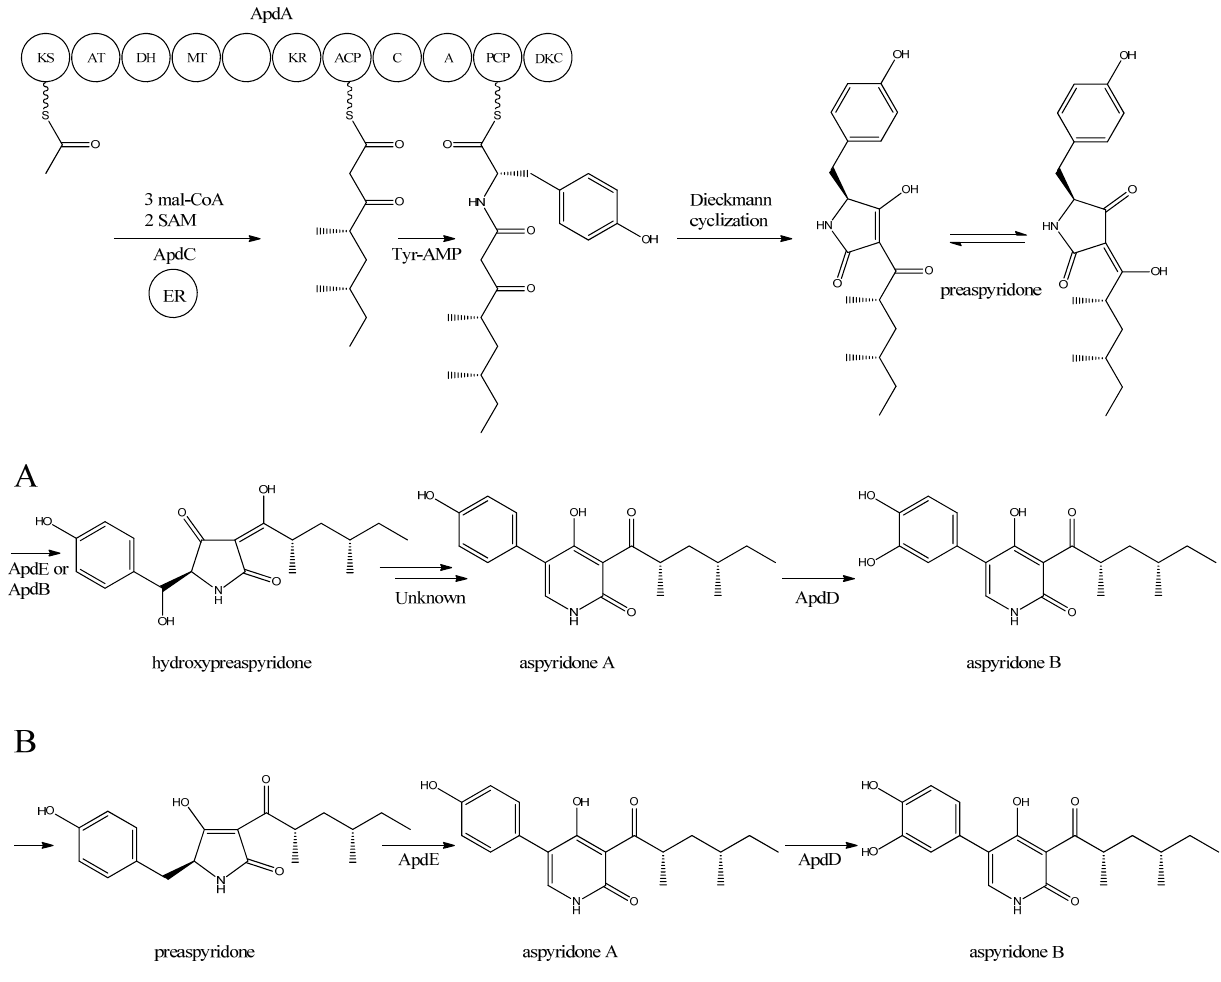
Figure 5. Proposed biosynthesis of aspyridone A and B. ( a ) Based on proposed biosynthesis by [68,72,73]; ( b ) Based on results by Halo et al. [78] Multiple arrows indicate that the number of enzymatic steps is